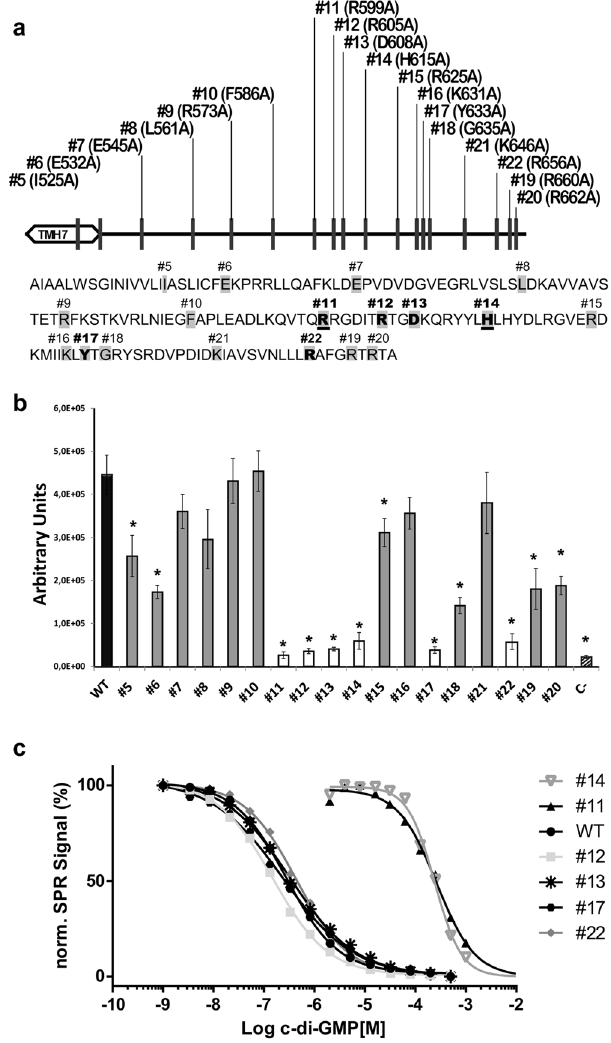
Figure 4. Effect of site-directed mutants on C-BgsA binding to c-di-GMP and BgsA activity. ( a ) Last predicted transmembrane helix of BgsA is indicated (TMH7). Positions mutated to alanine are in grey background. Those that showed MLG production < 10% of the wild type ( b ) are bold faced and those affected in the c-di-GMP binding ( c ) are underlined. ( b ) Quantification of MLG production as CF-derived fluorescence in S. meliloti 8530 bgsA under high intracellular c-di-GMP conditions (Tn7::Tc pleD * ) complemented with each of the 18 C-BgsA mutants indicated in ( a ). White bars depict mutants with less than 10% of the wild type MLG production. The wild type BgsA and the negative control (C-, empty vector pBBRMCS-5) are indicated with solid and striped black bars, respectively. Results are expressed in arbitrary units ± SD from four independent biological replicates. Asterisks indicate significant differences with the wild type on statistical homoscedastic two-tailed student’s t-test with P < 0.01. ( c ) Representative affinity fit for SPR competition experiments performed with 25 nM of C-BgsA wild type and mutants #12, #13, #17, #22 incubated for 2.5 hours with increasing c-di-GMP concentrations, from 0 to 500 µ M, and 100 nM of mutants #11 and #14 incubated for 2.5 hours with increasing c-di-GMP concentrations, from 0 to 1 mM. Sigmoidal dose-response curves for #11 and #14 were extrapolated and 0 RU were set to 0%. The different c-di-GMP concentrations are represented in Log scale and the SPR signal of the wild type and different mutants are normalized in